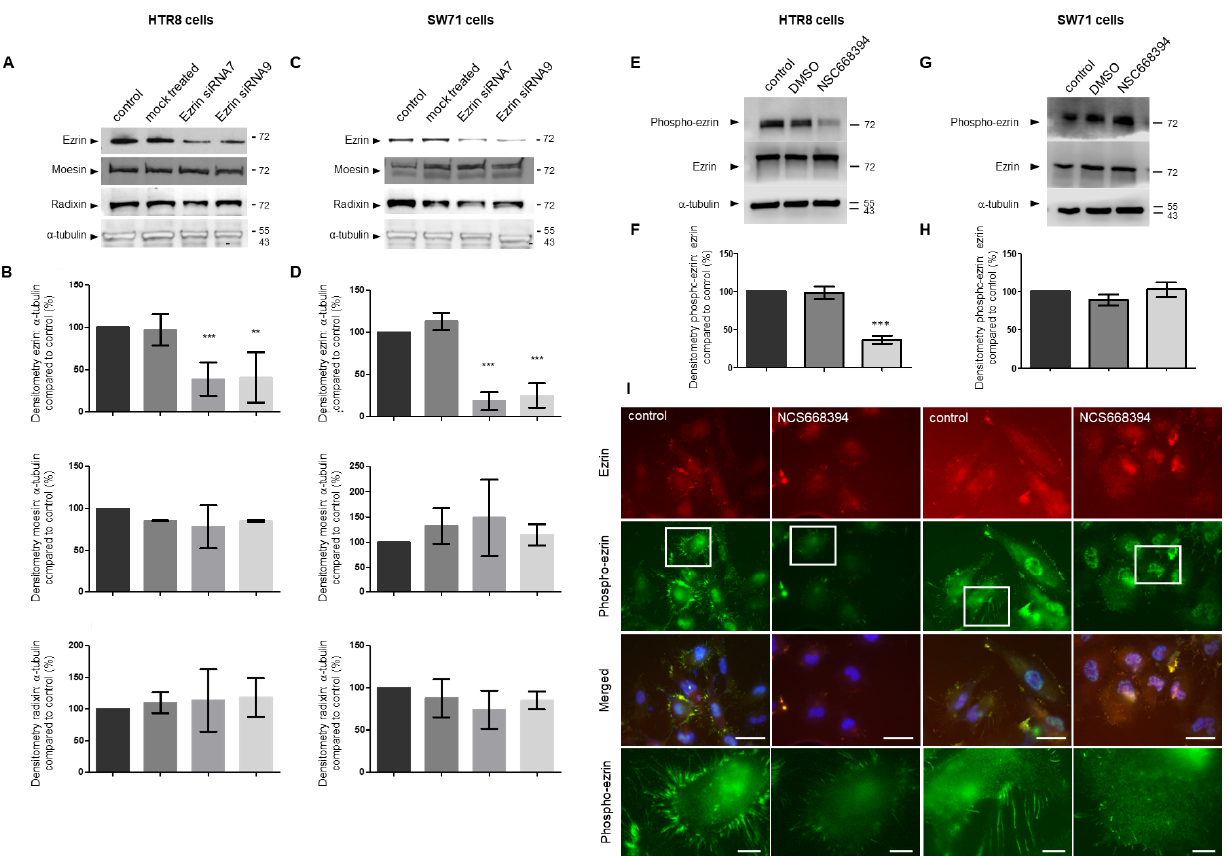
Figure 3. Specific knock-down of ezrin levels but not moesin or radixin or inhibitions of ezrin Thr567 phosphorylation in HTR8/SVneo and Swan71 trophoblastic cell lines. HTR8/SVneo and Swan71 cells were incubated in the presence of different ezrin siRNAs or control siRNAs for 72 h ( A – D ) or treated with NSC668394 inhibitors for 24 h ( E – I ) prior to collection for protein Western blotting ( A , C , E , G ) or immunofluorescence ( I ). For the determination of protein levels, cells were collected and solubilised in Lammeli buffer and equal loadings were separated by SDS-PAGE electrophoresis prior to PVDF transfer and Western blotting for ezrin, moesin, radixin or α -tubulin ( A , C ) or phosphor ezrin Thr567 ( E , G ), and cropped images are presented. The expression levels of ezrin, moesin and radixin or Thr567-phosphorylated ezrin and the effects of siRNAs or inhibitors, respectively, were measured by densitometric analysis, normalised to α -tubulin or ezrin and presented as percentage mean values ± SD of 3 independent samples of a representative experiment compared to non-treated control samples. ** p < 0.01 or *** p < 0.001 (one-way ANOVA). For all proteins, loading orders are the same as for the blots above ( B , D , F , H ). EVT-like lines HTR8/SVneo and Swan71 cells were seeded on fibronectin-coated coverslips and grown for 48 h prior to fixation, permeabilisation, and staining for ezrin and phospho-ezrin Thr567 ( I ). Cells were mounted and viewed using epifluorescence microscopy. Images in the last row correspond to the enlarged regions of the highlighted cells. Bar corresponds to 25 µ m in the wide views and 5 µ m in the zoomed-in